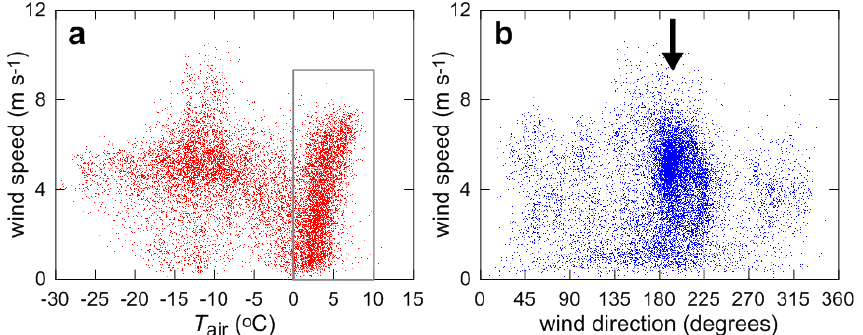
Figure 8. Scatter plots showing relations between u , T air and WD. In both panels ( a and b ) all the available measurements are shown, and every dot represents a half-hourly mean value. The inset in (a) highlights the relationship between u and T air above 0 ◦ C. The arrow in (b) indicates the direction of the local flow line of the